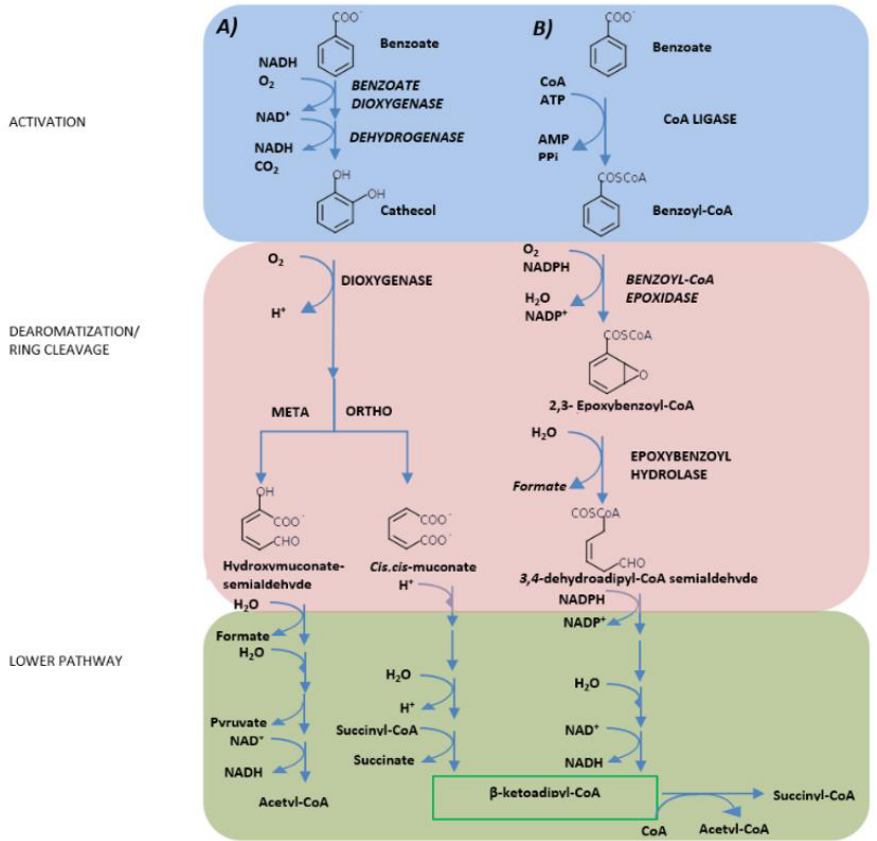
Figure 1. Benzoate can be aerobically catabolized following two major strategies: ( A ) classical aerobic biodegradation pathway and ( B ) aerobic hybrid pathway. In both strategies, an activation step (blue), dearomatization/ring-cleavage step (pink) and further degradation to central metabolites, that is, lower pathway step (green), can be identified. The ortho cleavage of catechol (b-ketoadipate central pathway) and the benzoyl-CoA hybrid pathway converge into the common b-ketoadipyl-CoA intermediate. The anaerobic degradation of benzoate shares a similar initial reaction with the aerobic hybrid pathway catalyzed by a benzoate-CoA ligase.